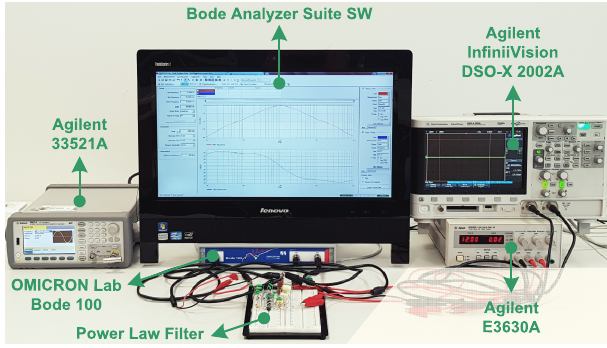
Figure 9. Photograph of the experimental